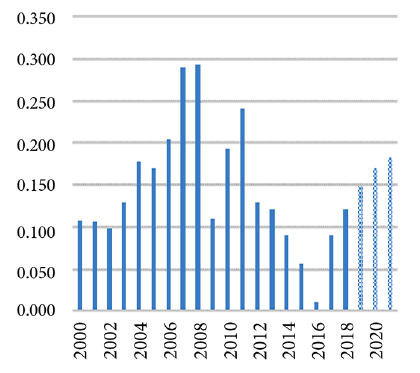
Figure 1. Economic growth tempo of China, 2000–2021, % (source: authors’ researches)